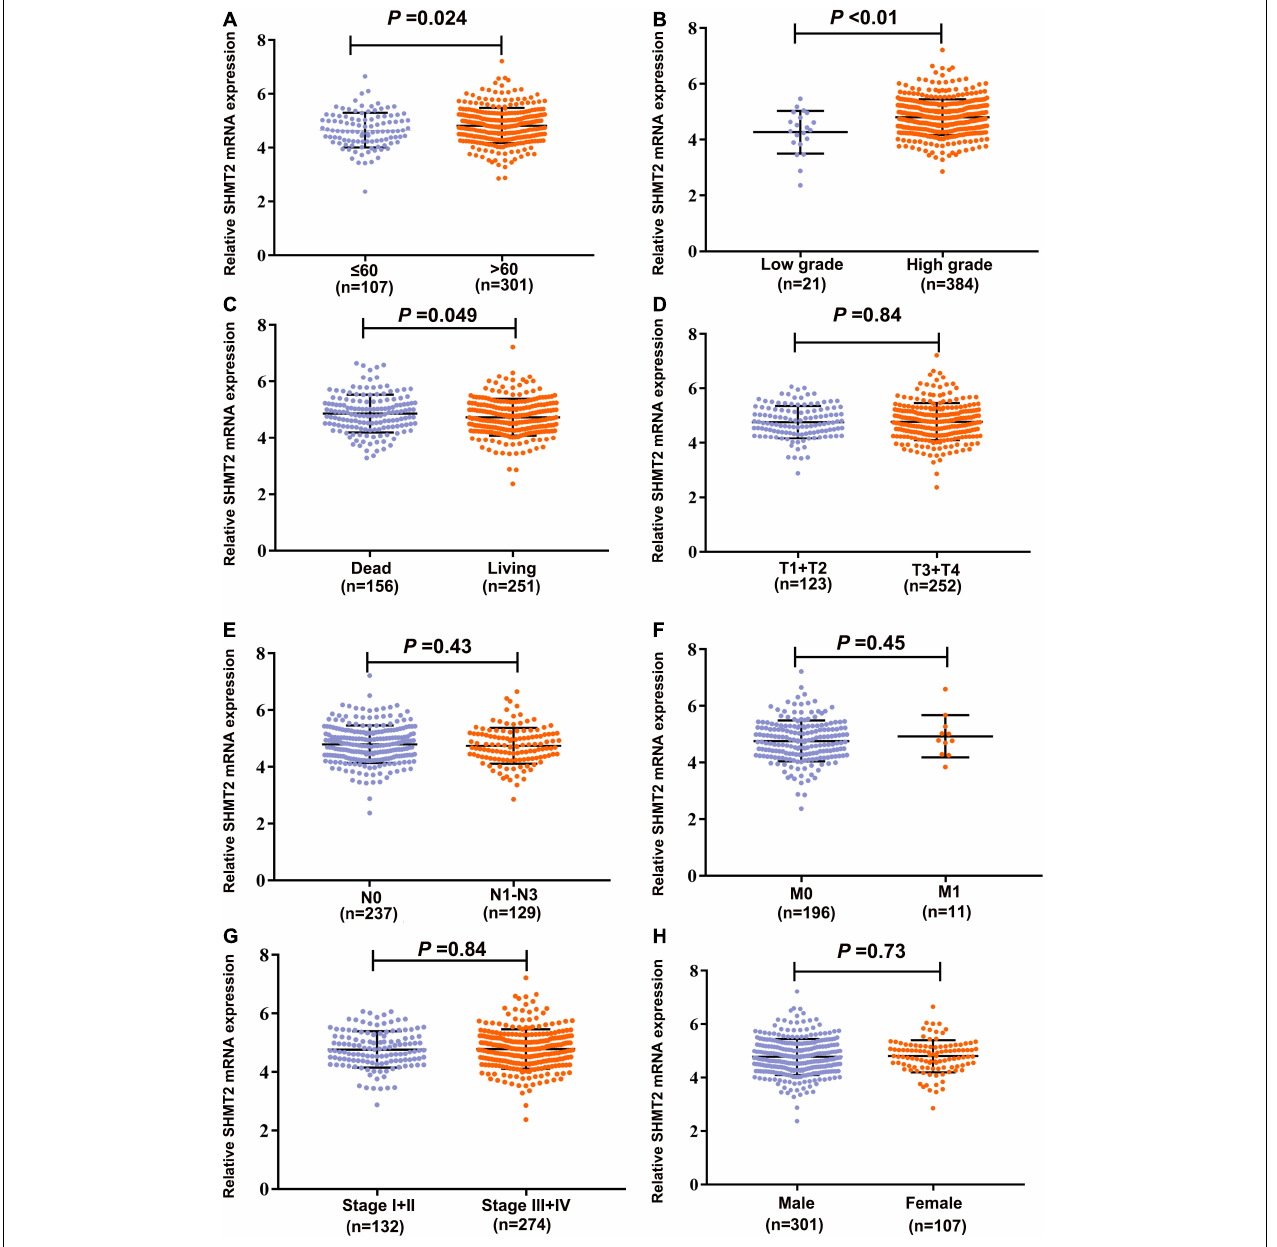
FIGURE 4 | Correlation analyses between SHMT2 expression and different clinicopathological characteristics of BLCA patients. The association between SHMT2 expression and clinicopathological characteristics of BLCA patients, including (A) Age ( P = 0.024); (B) Tumor grade ( P < 0.001); (C) Overall survival ( P = 0.049); (D) Tumor (T) stage ( P = 0.84); (E) Node (N) stage ( P = 0.43); (F) Metastasis (M) stage ( P = 0.45); (G) Tumor node metastasis (TNM) stage ( P = 0.84); (H) Gender ( P = 0.73). P < 0.05 was recognized as statistically significant.